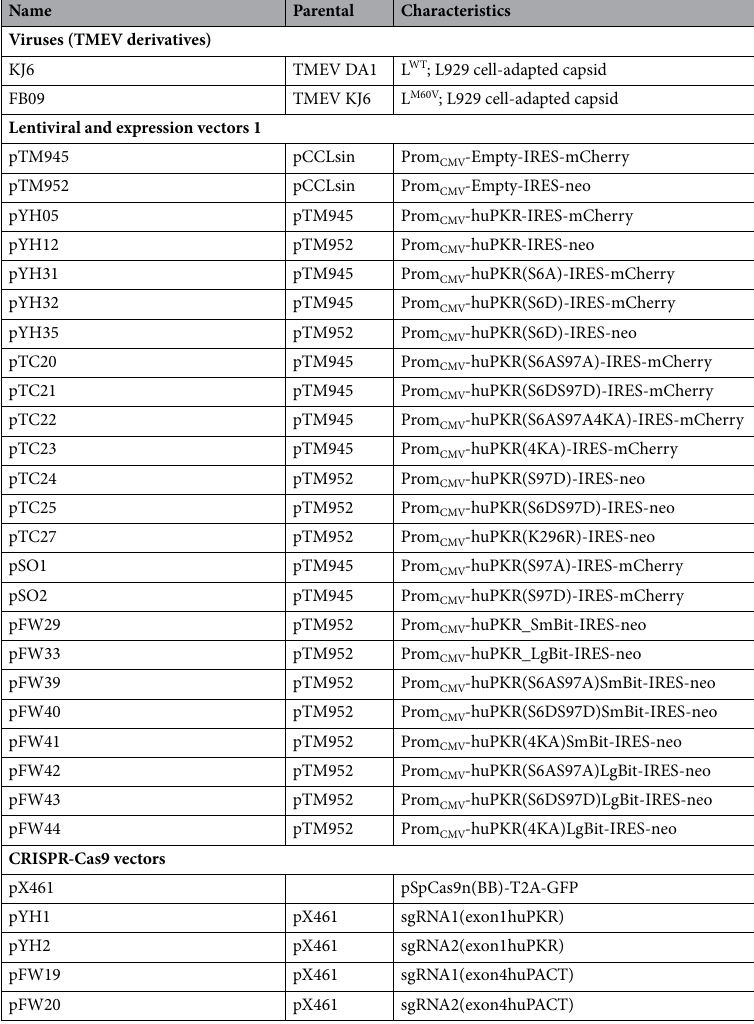
Table 1. Plasmids and viruses used in this study. These plasmids were generated in a lentiviral vector backbone. They are named pTM, pYH, pTC… when used as expression plasmids, and TM, YH, TC… when used as lentiviral